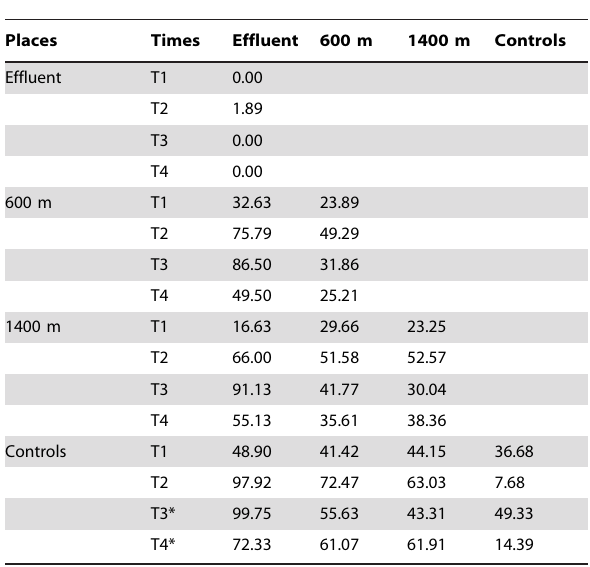
Table 8. Average dissimilarities among and within the sites sampled at the discharge point (Effluent), 600 and 1400 m away from the discharge areas (600 m and 1400 m, respectively) and control sites (C1 and C2), in each time.